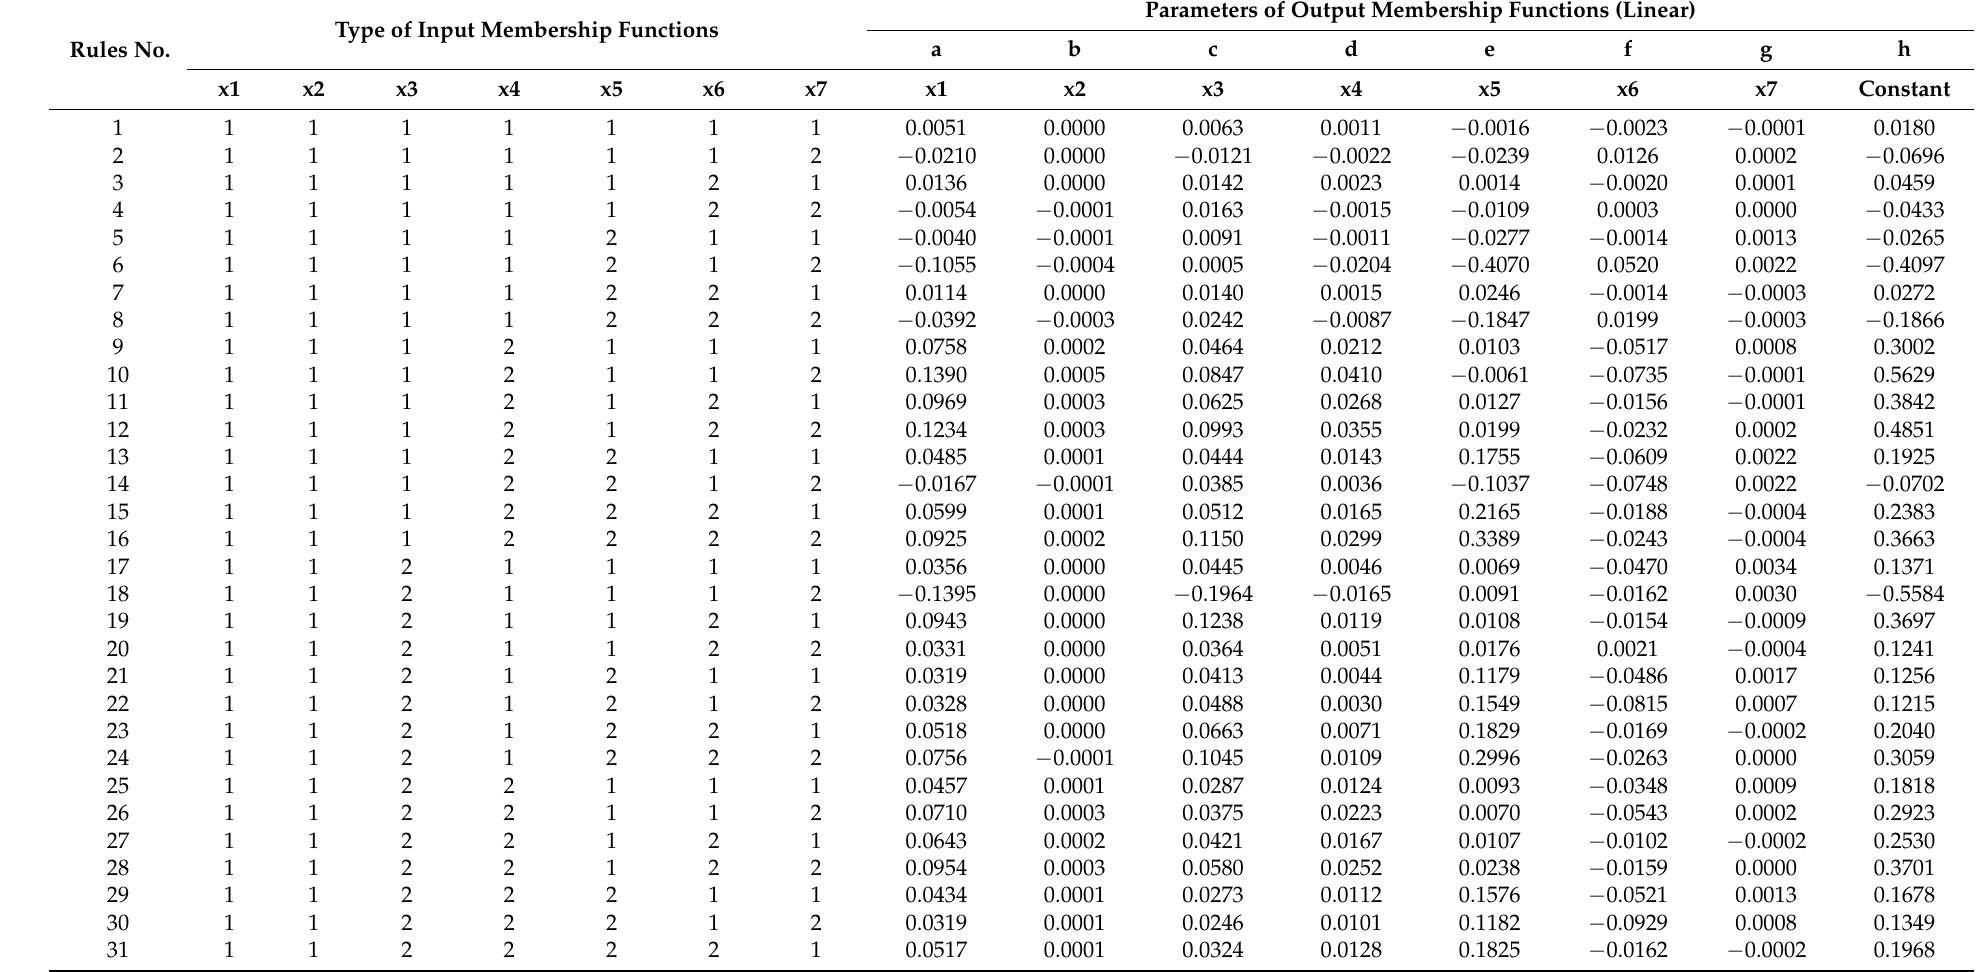
Table A1. Membership functions and